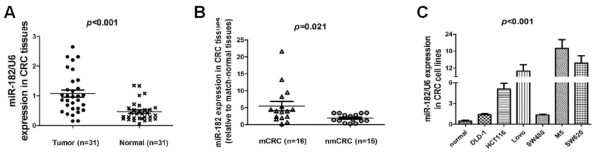
The expression of miR-182 was up-regulated in CRC cells and tissue specimens using quantitative real-time polymerase chain reaction (qRT-PCR). (A) The expression levels of mature miR-182 in paired CRC and adjacent normal tissues. (B) The miR-182 expression in CRC tissues with or without metastases relative to match-normal tissues. nmCRC denotes CRC tissues without metastases; mCRC denotes CRC tissues with lymph node metastases. (C) The relative expression of miR-182 in CRC cells and normal tissues samples. miRNA abundance was normalized to U6 RNA.